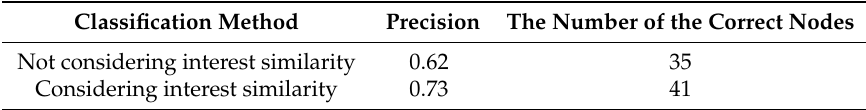
Table 4. Results in different classification methods.